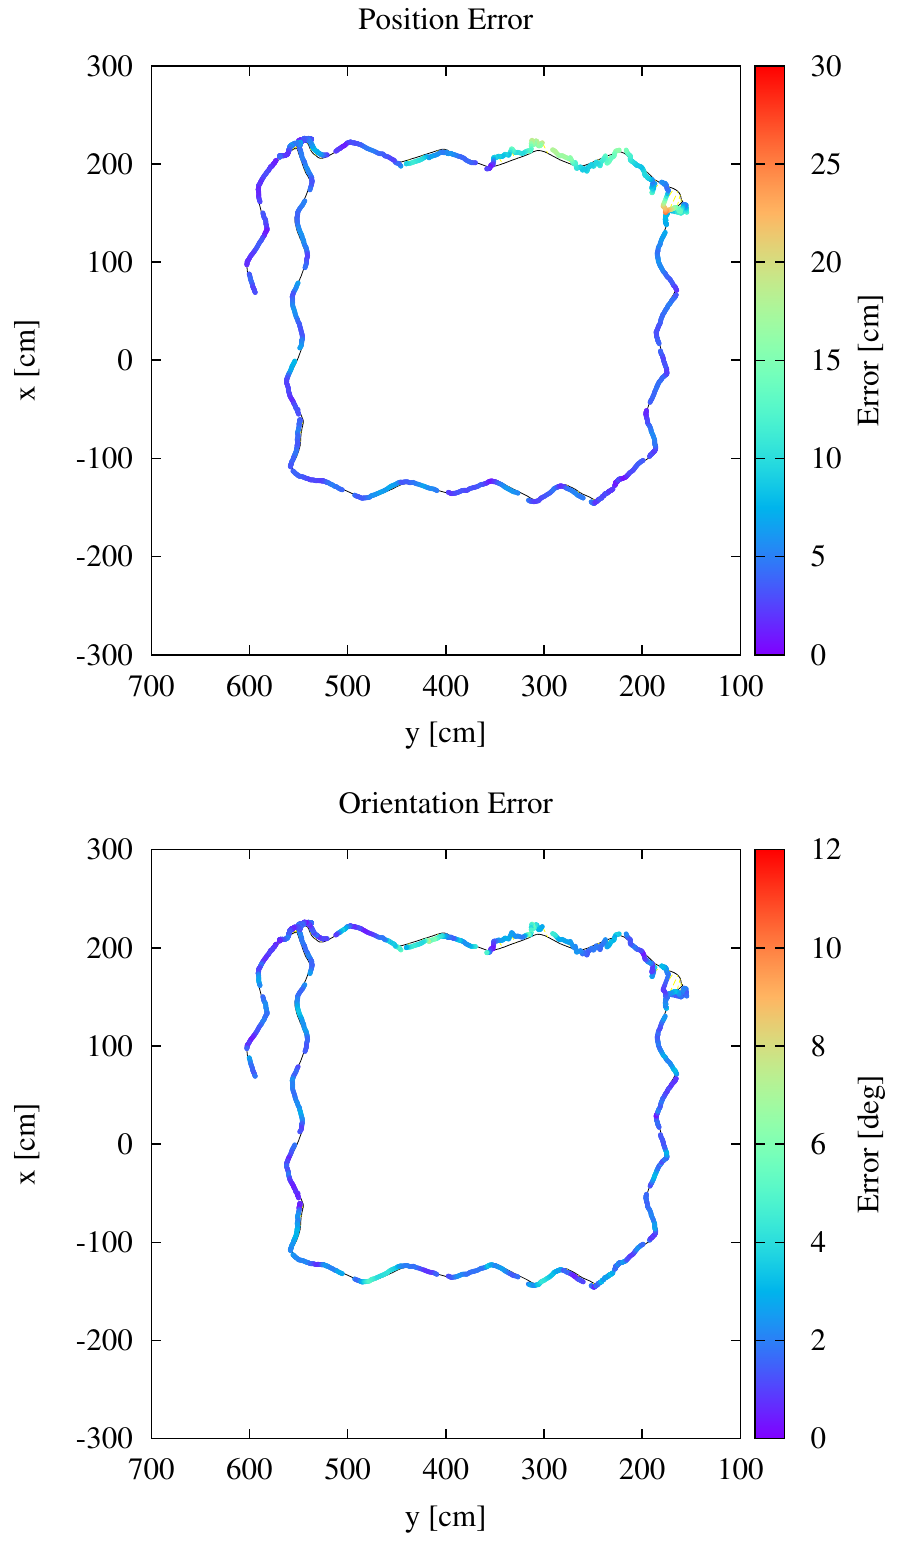
Figure 14. Experiment 2. ( Top ): position error. ( Bottom ): orientation